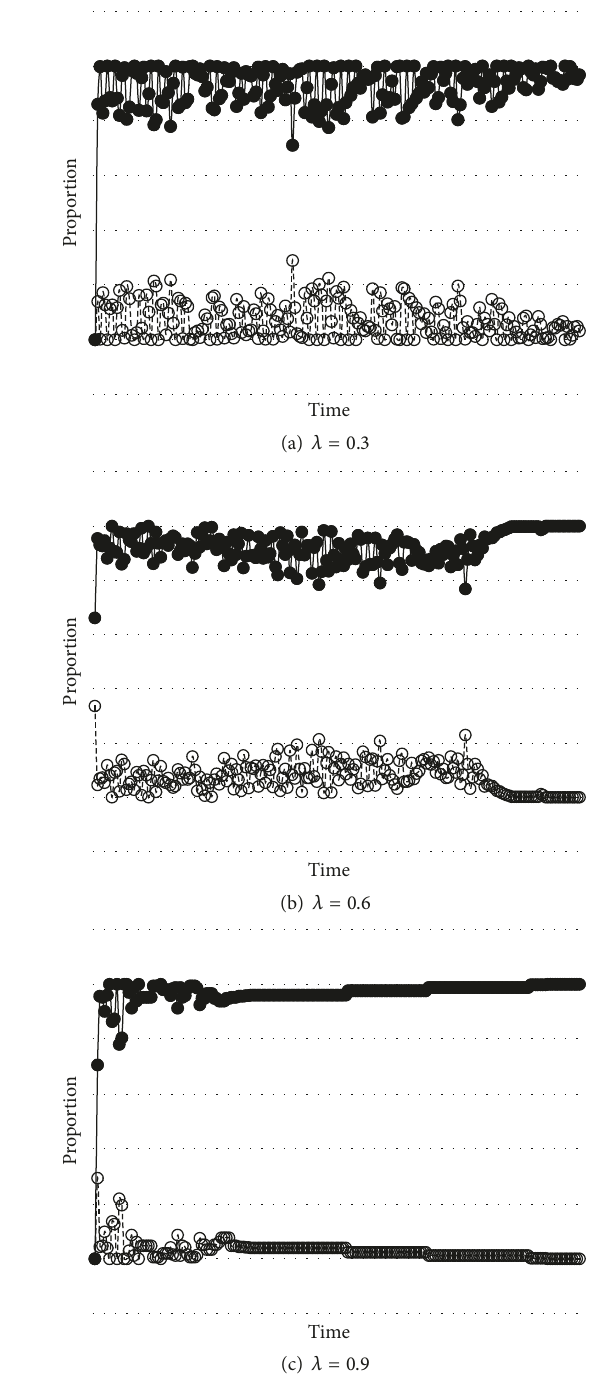
Figure 4: The evolutionary trend of the consumers’ strategy selec- tion in model